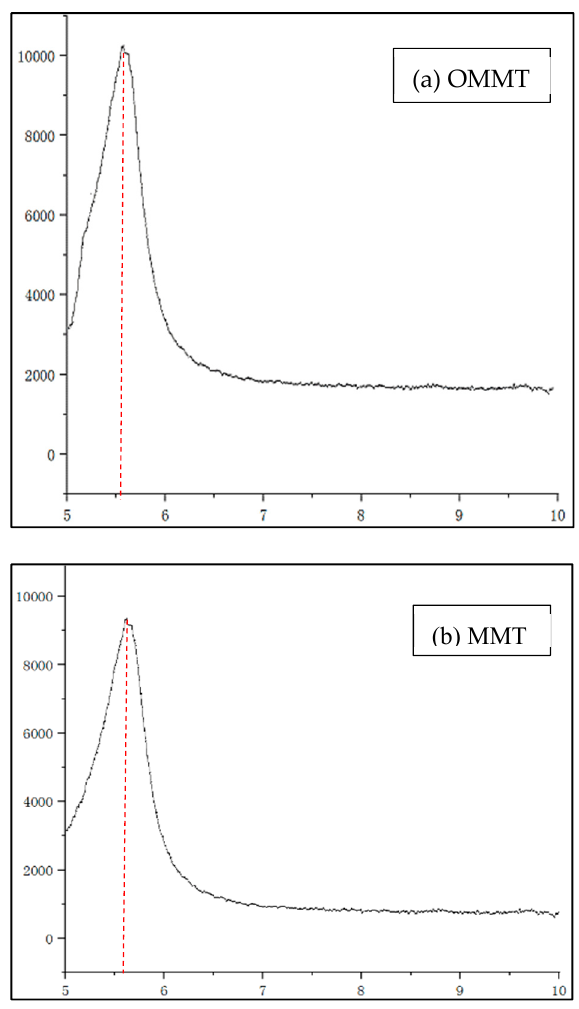
Figure 7. XRD patterns of OMMT ( a ) and MMT ( b ).